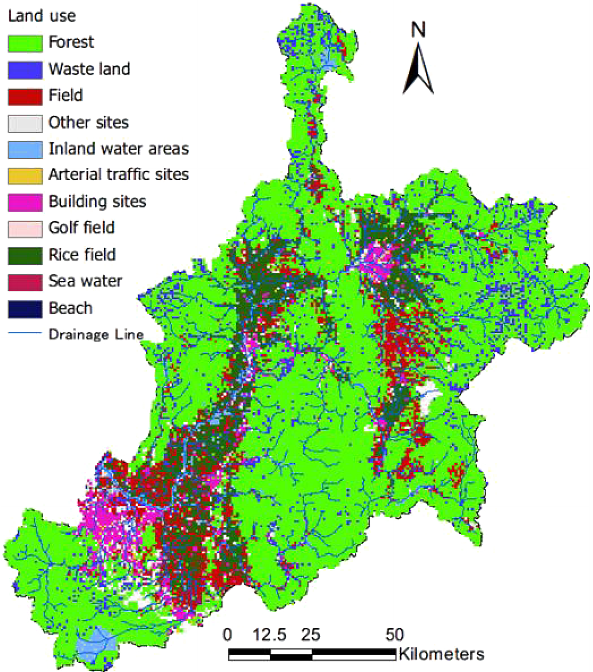
Figure 4. Land use of the Ishikari River basin,